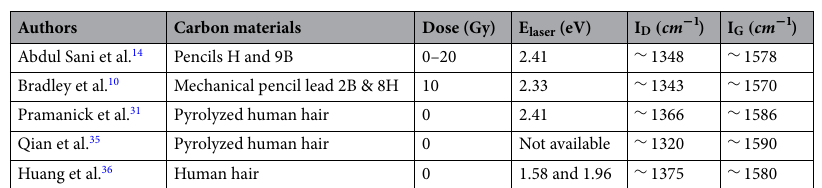
Figure 3. ( a ) First- and second-order Raman spectra of hair irradiated to various doses of Typical Raman spectra in a region extending from 1000 to 1800cm − deconvoluted peaks with their correspondingly labelled wavenumbers.